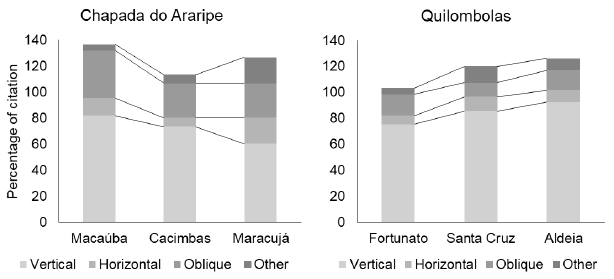
Fig. 5 . Learning about medicinal plants in Araripe communities (Macaúba n = 22 interviews, Cacimbas n = 15 interviews, Maracujá n = 15 interviews) and Quilombola communities (Morro do Fortunato n = 63 interviews, Santa Cruz n = 56 interviews, Aldeia n = 65